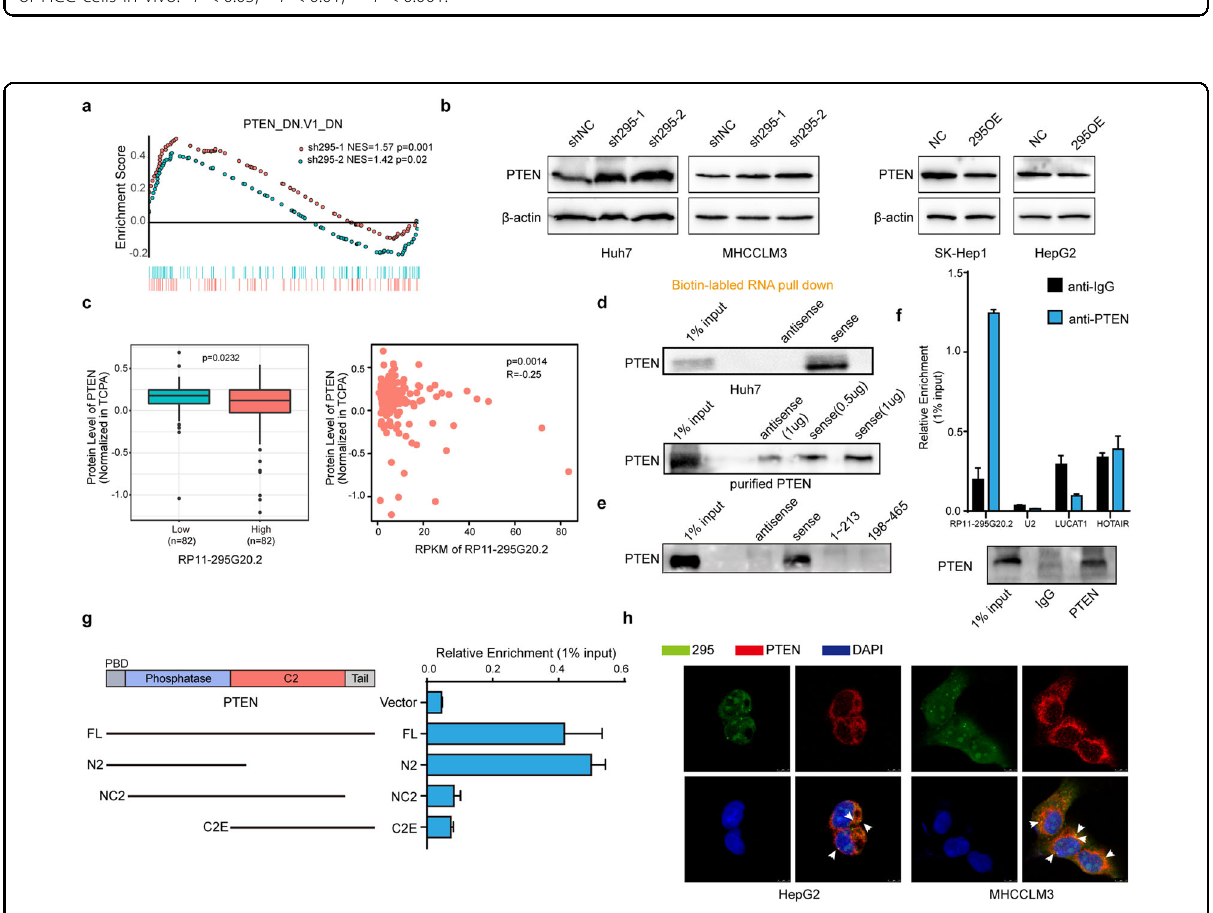
Fig. 3 RP11-295G20.2 reduces PTEN protein expression and interacts with the PTEN protein. a The set of RP11-295G20.2-regulated genes is enriched with PTEN-regulating genes. b RP11-295G20.2 downregulates the PTEN protein expression. The expression of PTEN protein was analyzed by western blotting in control or RP11-295G20.2 knockdown/overexpressing cells. c RP11-295G20.2 expression is negatively associated with PTEN protein expression in HCC samples. d RP11-295G20.2 interacts with the PTEN protein, as evidenced by RNA pulldown assays. Upper: RNA pulldown with cell lysates; Lower: RNA pulldown with puri fi ed PTEN protein. e Truncated RP11-295G20.2 RNA pulldown experiment indicated that Truncated RP11-295G20.2 did not bind to PTEN protein. f PTEN protein is coimmunoprecipitated with RP11-295G20.2 in RIP assays. U2, LUCAT1 and HOTAIR were used as negative control lncRNAs. g The PBD domain of PTEN is essential for the interaction of RP11-295G20.2 with the PTEN protein. Truncated PTEN fragments were transfected into HCC cells and the binding of RP11-295G20.2 was analyzed by RIP assays. h RP11-295G20.2 colocalized with the PTEN protein in HCC